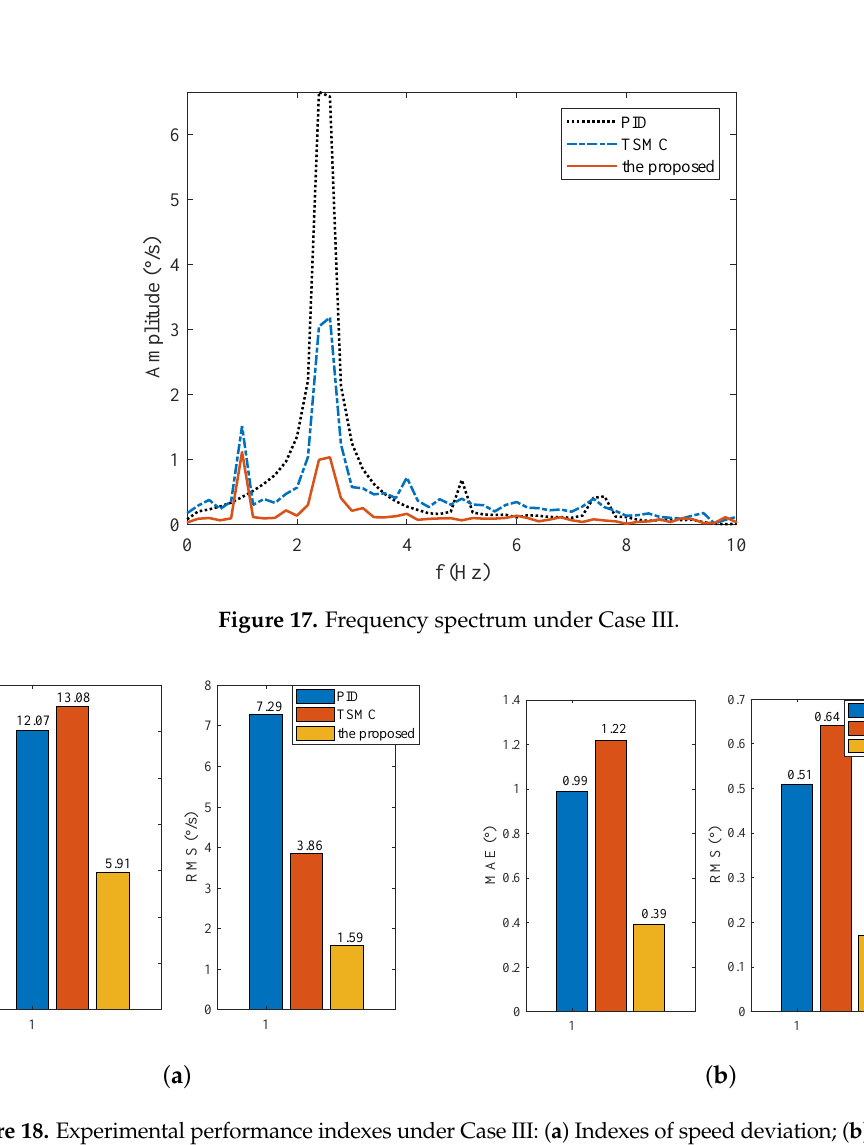
Figure 18. Experimental performance indexes under Case III: ( a ) Indexes of speed deviation; ( b ) indexes of angular